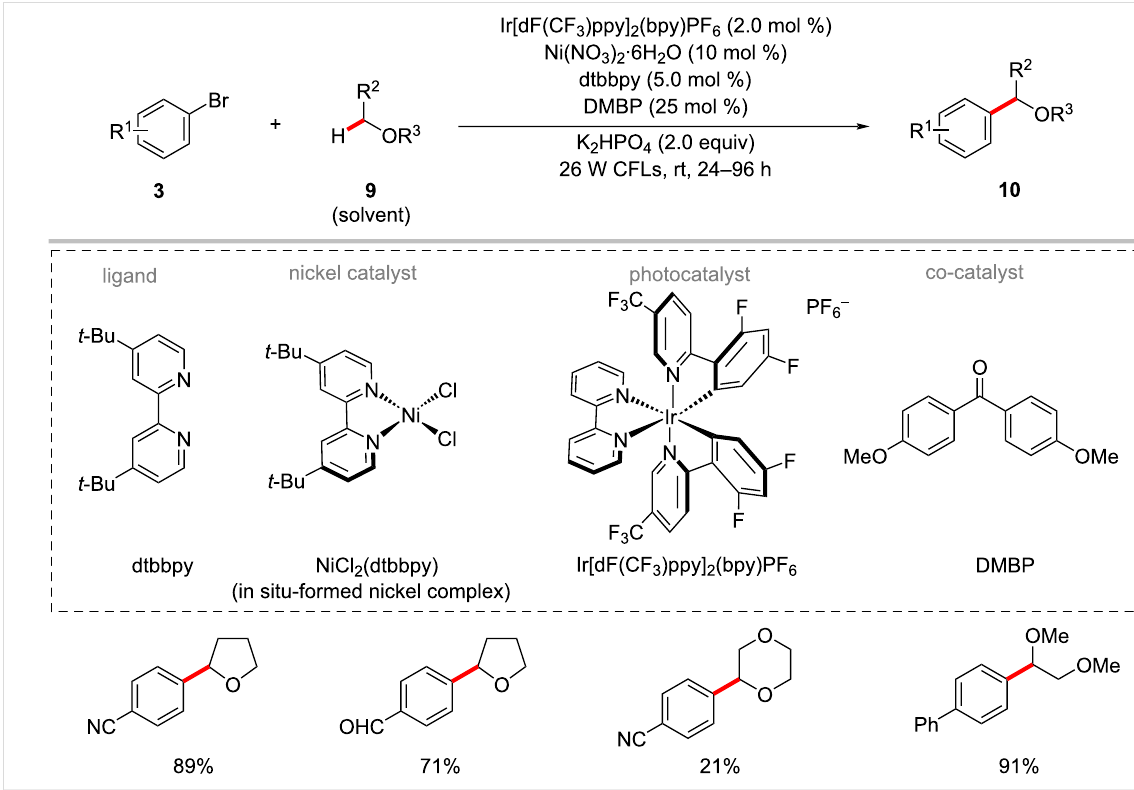
Scheme 6: Photochemical nickel-catalyzed C–H arylation of ethers.